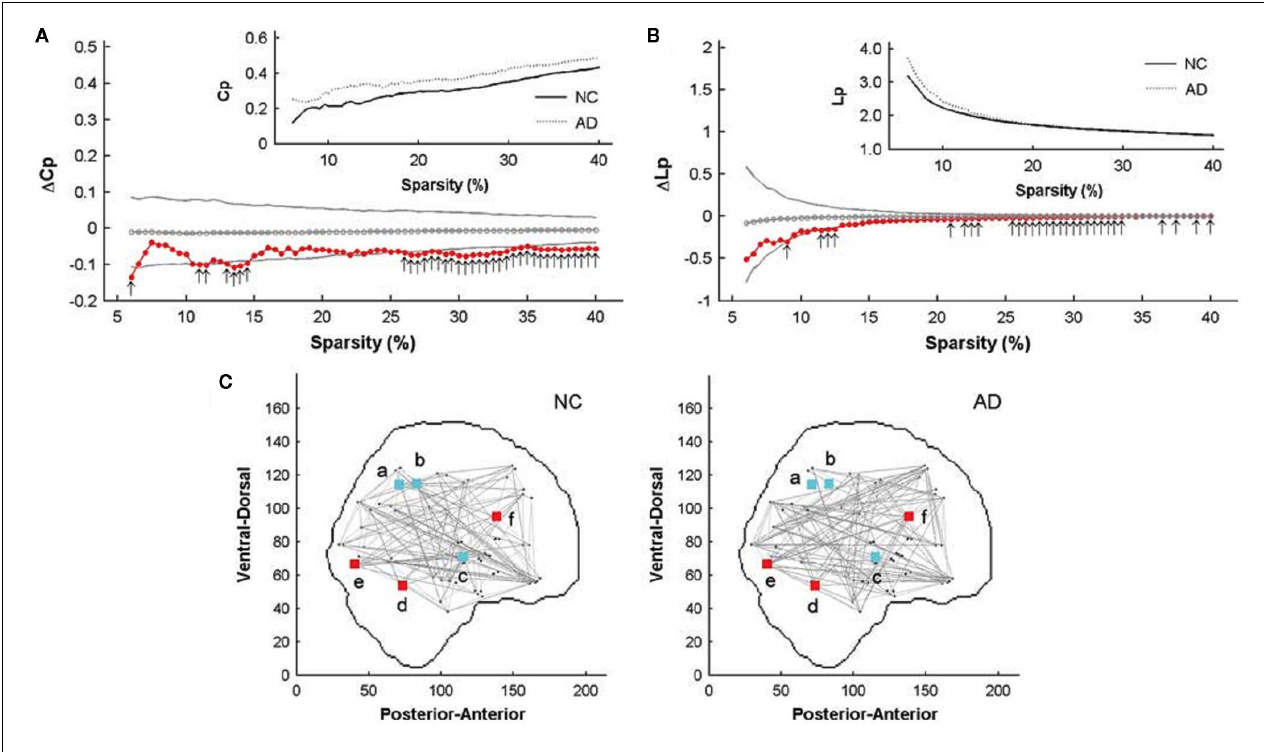
significantly different betweenness in the AD group compared with the healthy control group. Red regions have significantly increased betweenness in the AD group and cyan regions have decreased values of betweenness.The small letters a through f represented the right angular gyrus, the left angular gyrus, the right superior temporal gyrus, the left lateral occipitotemporal gyrus, the right lingual gyrus, and the left cingulate gyrus,